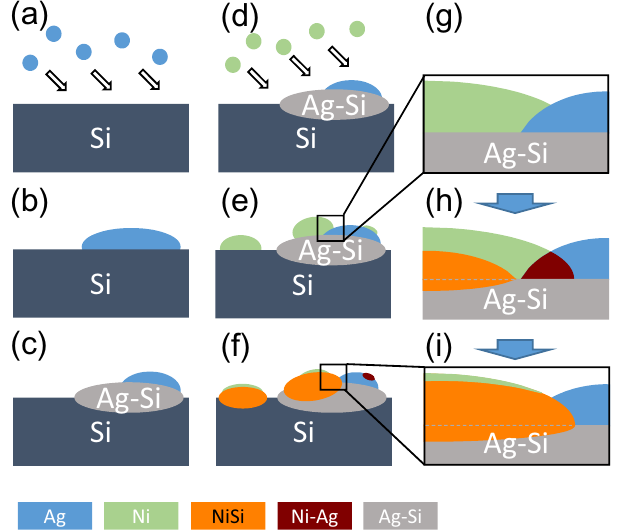
Figure 5. Schematic plots showing distribution of different species after Ni deposition with enhanced silicide